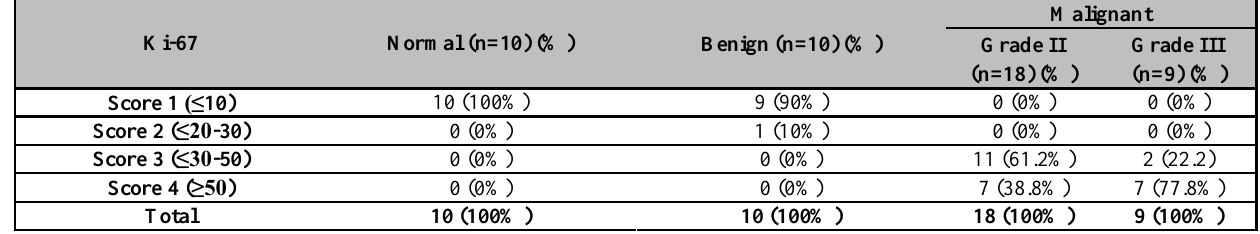
Table 2. Percentage of the Ki67 scores positive expression in individual cases.